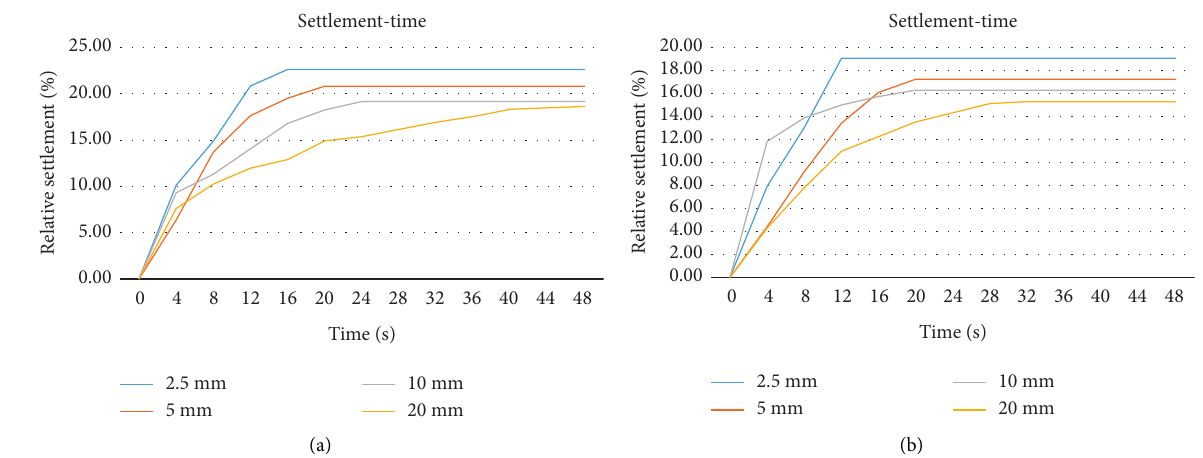
Figure 16: Percentage of relative settlement over time for round and sharp corner aggregates with uniform granulation.